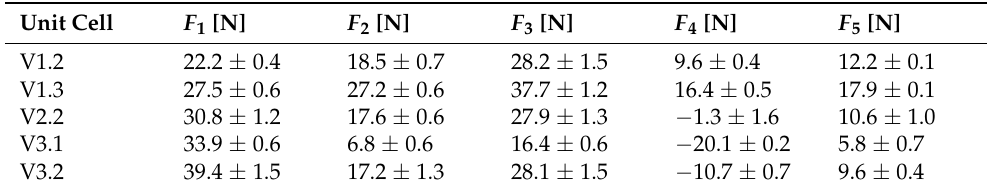
Table 2. Characteristic forces F 1 to F 5 and their standard deviation based on the force–displacement curve of the 4th load cycle. The numbers 1 to 5 refer to the different states during compression and unloading (cf. Figure